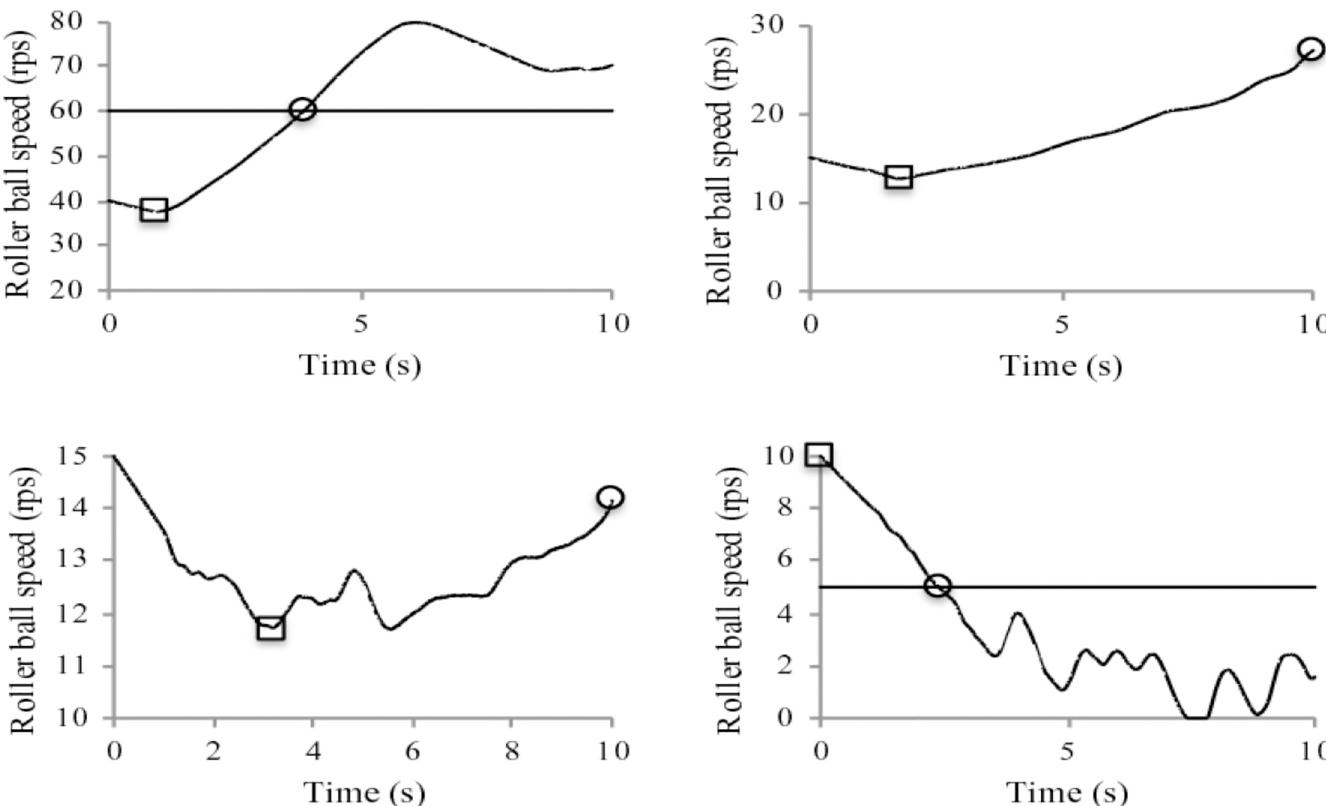
Fig 2. Example roller ball speed profiles and the identification of the beginning and end of the slope calculation of individual trials. The 10 s trial starts when the rollerball speed reached the initial speed of the condition. The square markers represent the beginning and the circle markers indicate the end of the slope calculations.